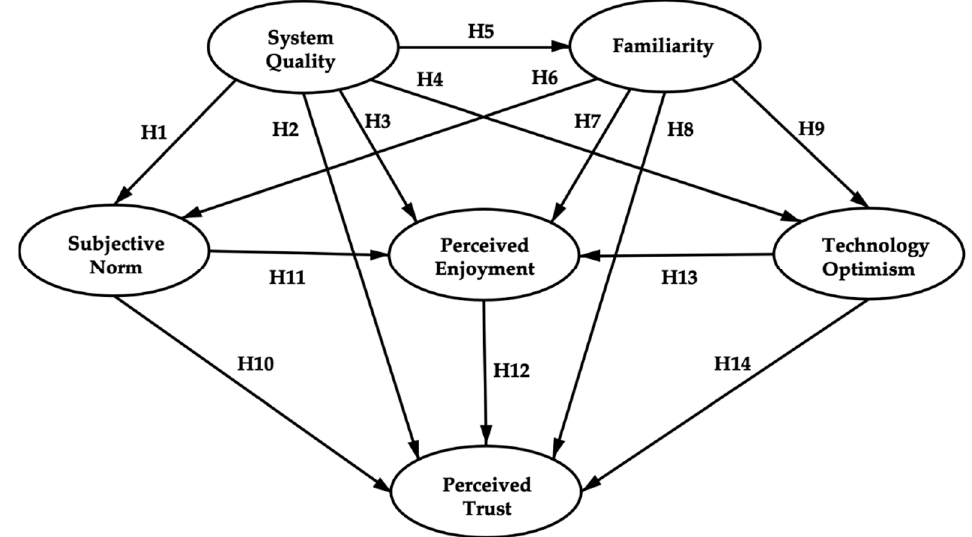
Figure 1. The conceptual framework of hypotheses.